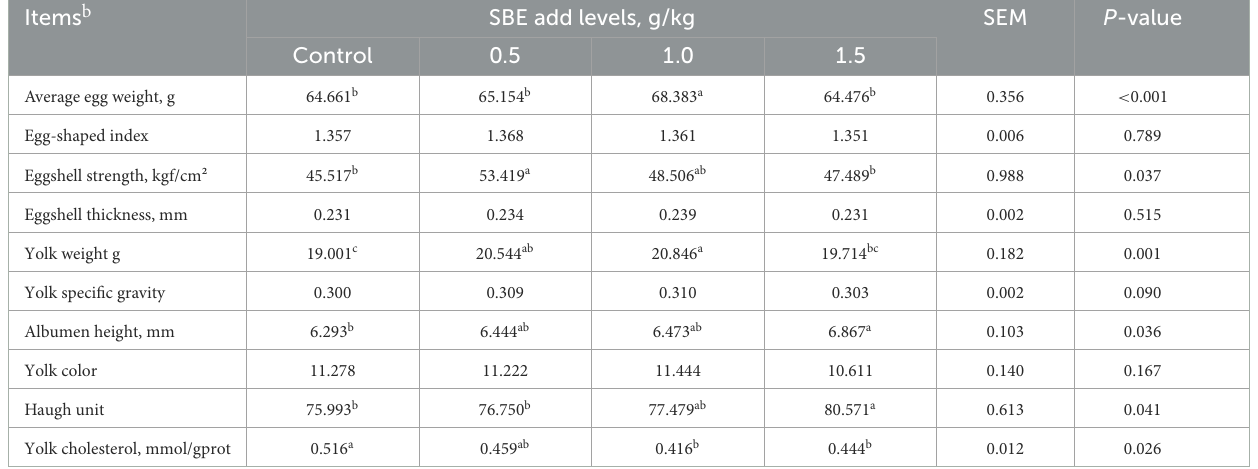
TABLE 4 Effect of dietary SBE on egg quality of laying ducks a . Items